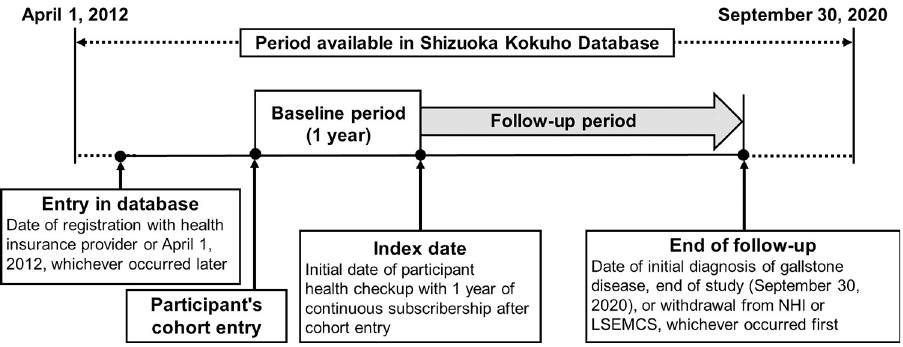
Fig 1. Study schema. Cohort entry is defined as the date of registration with the health insurance provider or April 1, 2012, whichever occurred later. The index date is defined as the initial date of annual health checkups with � 1 year continuous subscribership to the health insurance system. “Follow-up period” is defined as the interval between the index date and (1) the end of the study (September 30, 2020) or (2) the withdrawal date from the health insurance system, whichever occurred